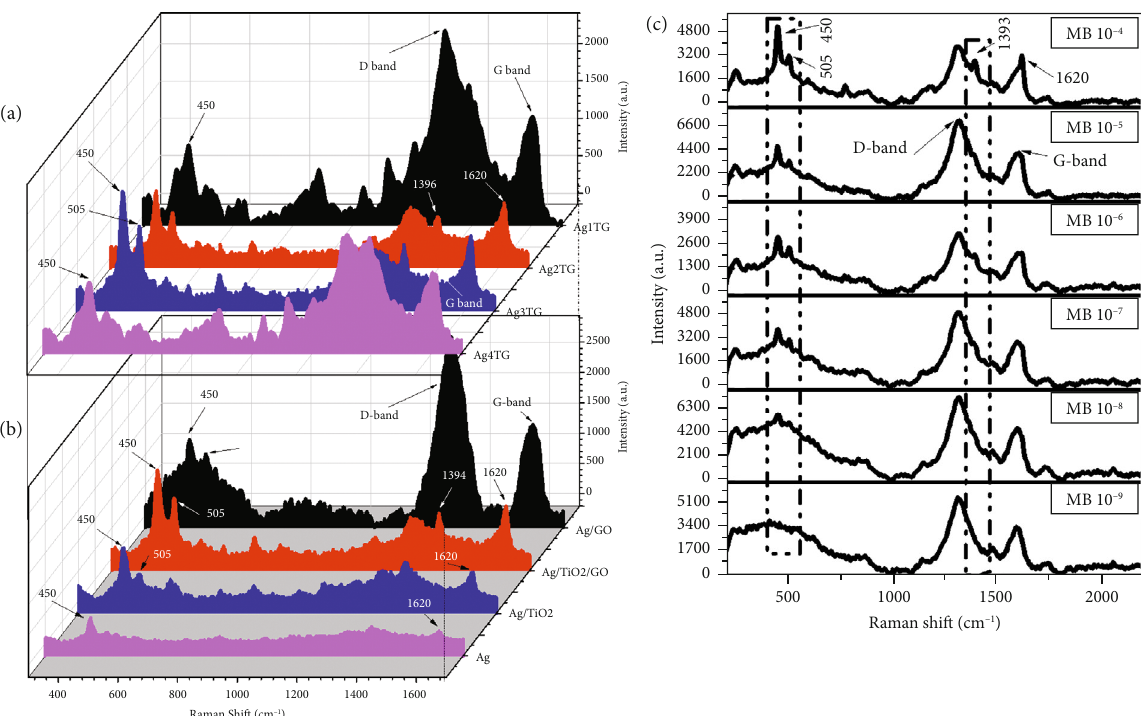
Figure 3: SERS spectra of MB (10 -6 M) in the presence of ATG Nces with di ff erent Ag contents (A1TG, A2TG, A3TG, and A4TG) (a), and Ag-containing materials including Ag NPs, Ag/TiO 10 -9 M) in the presence of A3TG